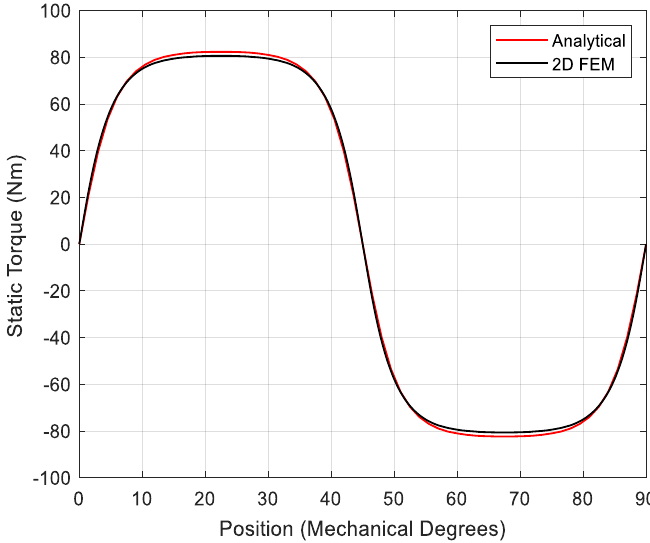
Figure 8. Static torque: 2D FEM (black) and analytical (red).